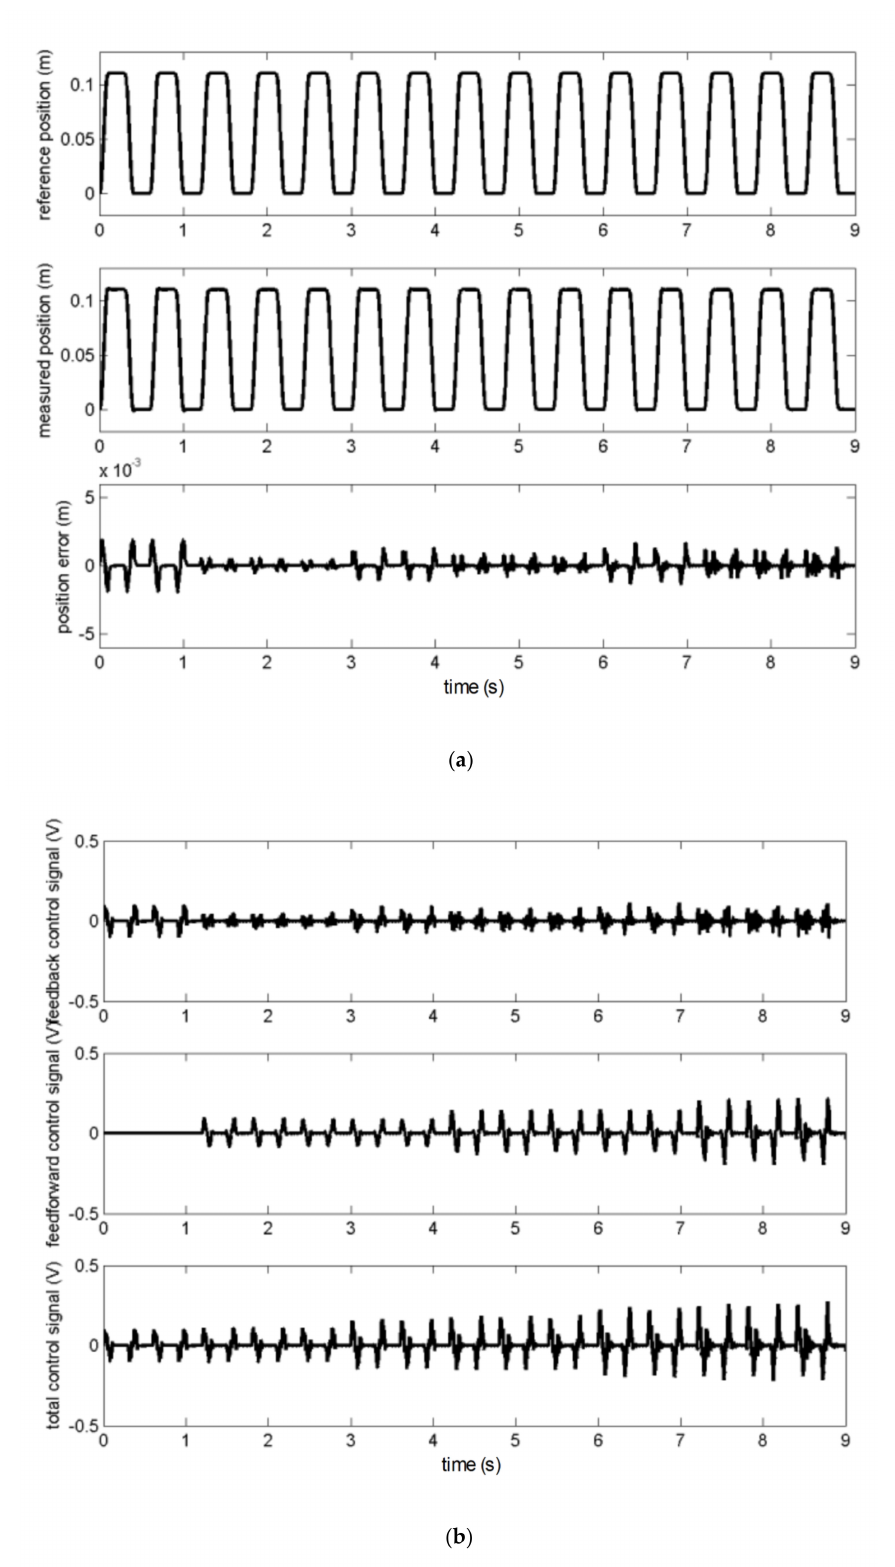
Figure 8. The first test without the effect of nonlinear cogging and friction force: ( a ) position error; ( b ) control